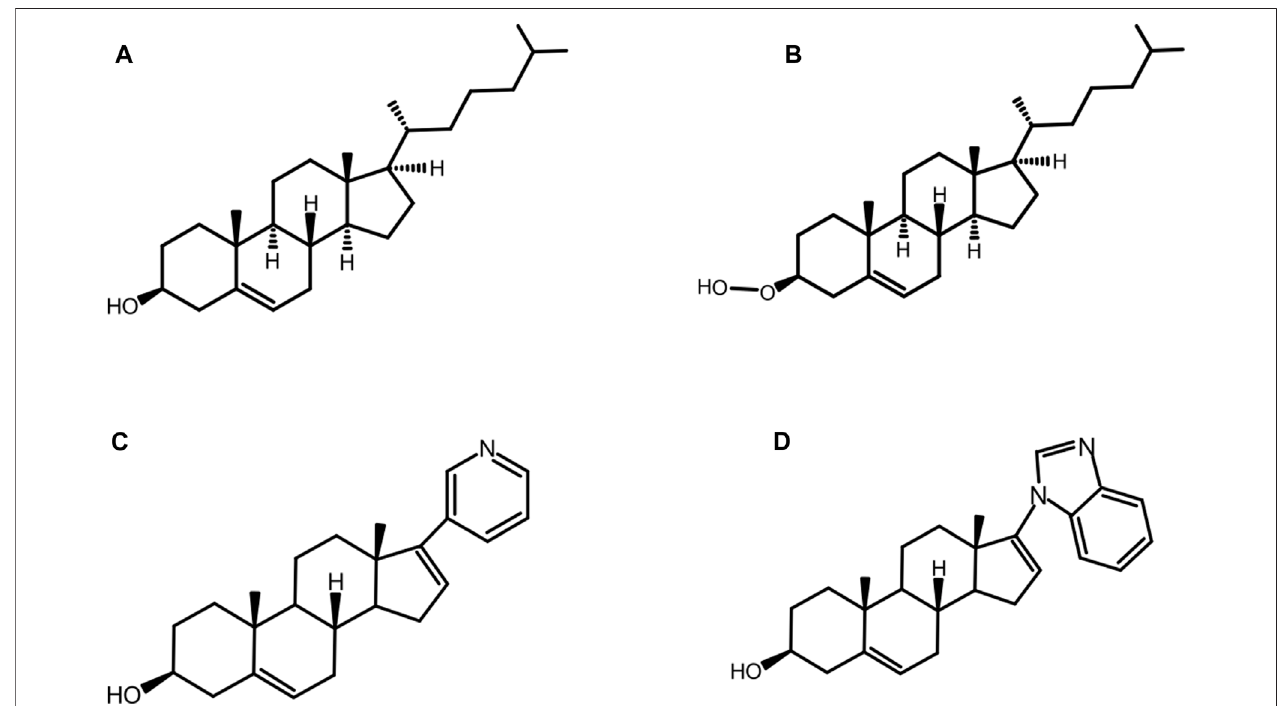
FIGURE8| Nativeandnon-nativesubstrates.Structureofnativesubstrate:cholesterol (A) andnon-nativesubstrates:3-hydroperoxycholestane:3-HPC,atypeof hyper nucleophilic sterol substrate (B) , abiraterone (C) , and galeterone (D) for HhC autoprocessing.